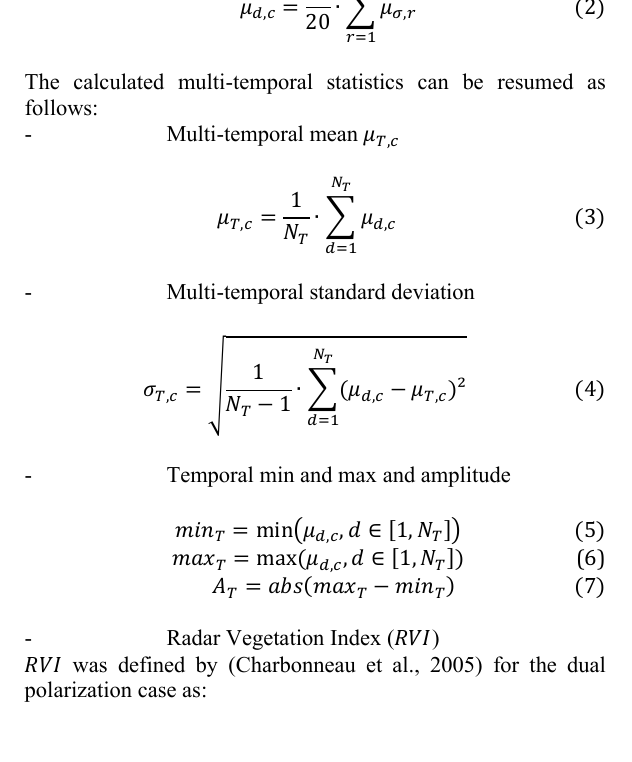
statistical parameters were calculated based on the averaged backscatter values of the 20 reference patches, for each class.